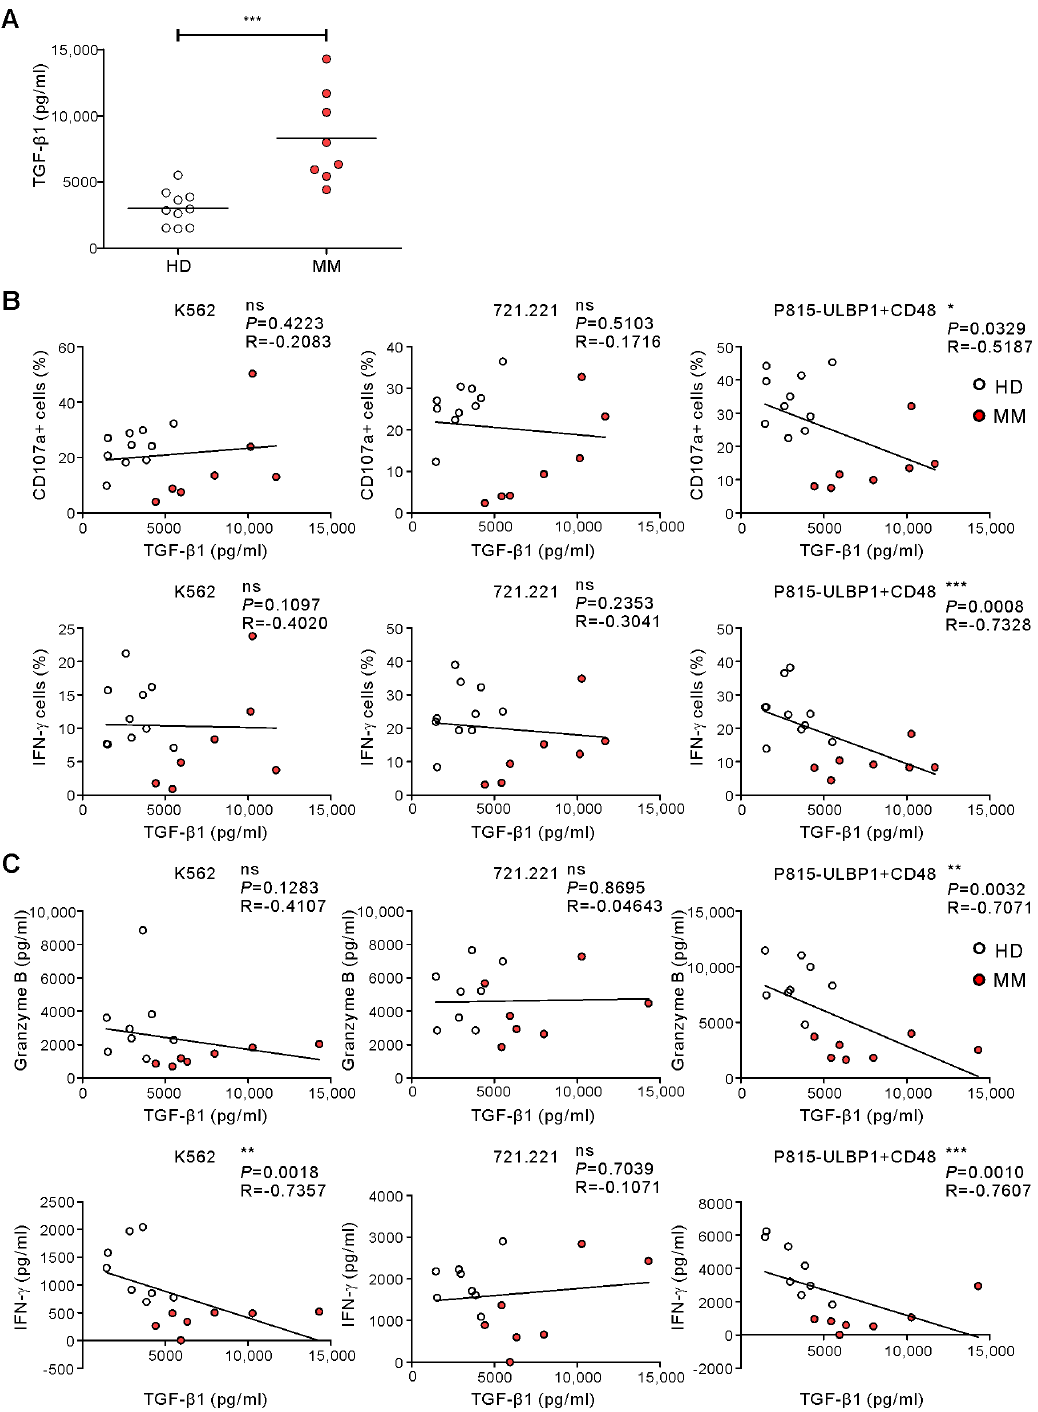
Figure 5. Correlation between the levels of TGF- β 1 and impaired NKA in response to receptor coactivation. ( A ) The plasma levels of TGF- β 1 was measured by ELISA in the HD group ( n = 10) and MM group ( n = 8). Horizontal bars denote the medians. ( B ) Correlation between plasma TGF- β 1 levels and the percentages of CD107a+ or IFN- γ + NK cells. ( C ) Correlation between plasma TGF- β 1 levels and the levels of granzyme B or IFN- γ release. * p < 0.05, ** p < 0.01, and *** p < 0.001; Mann–Whitney U-test ( A ) and Spearman’s correlation test ( B , C ).